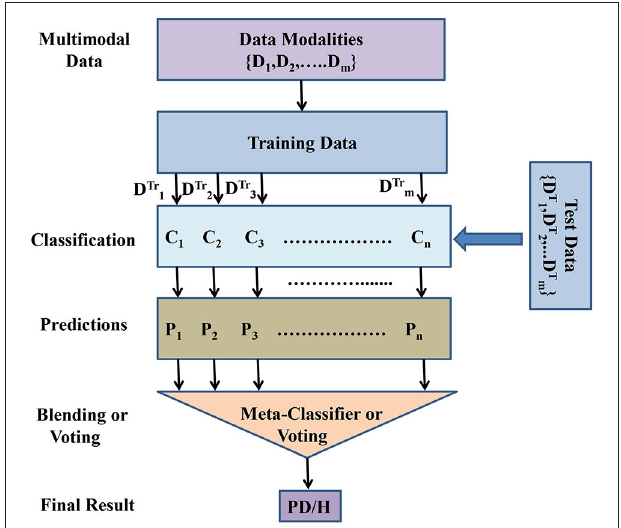
FIGURE 1 | Block diagram of the proposed MultiModal Data–Driven Ensemble (MMDD-Ensemble) model. D i : The i th data modality. D Tr i : Training data of the